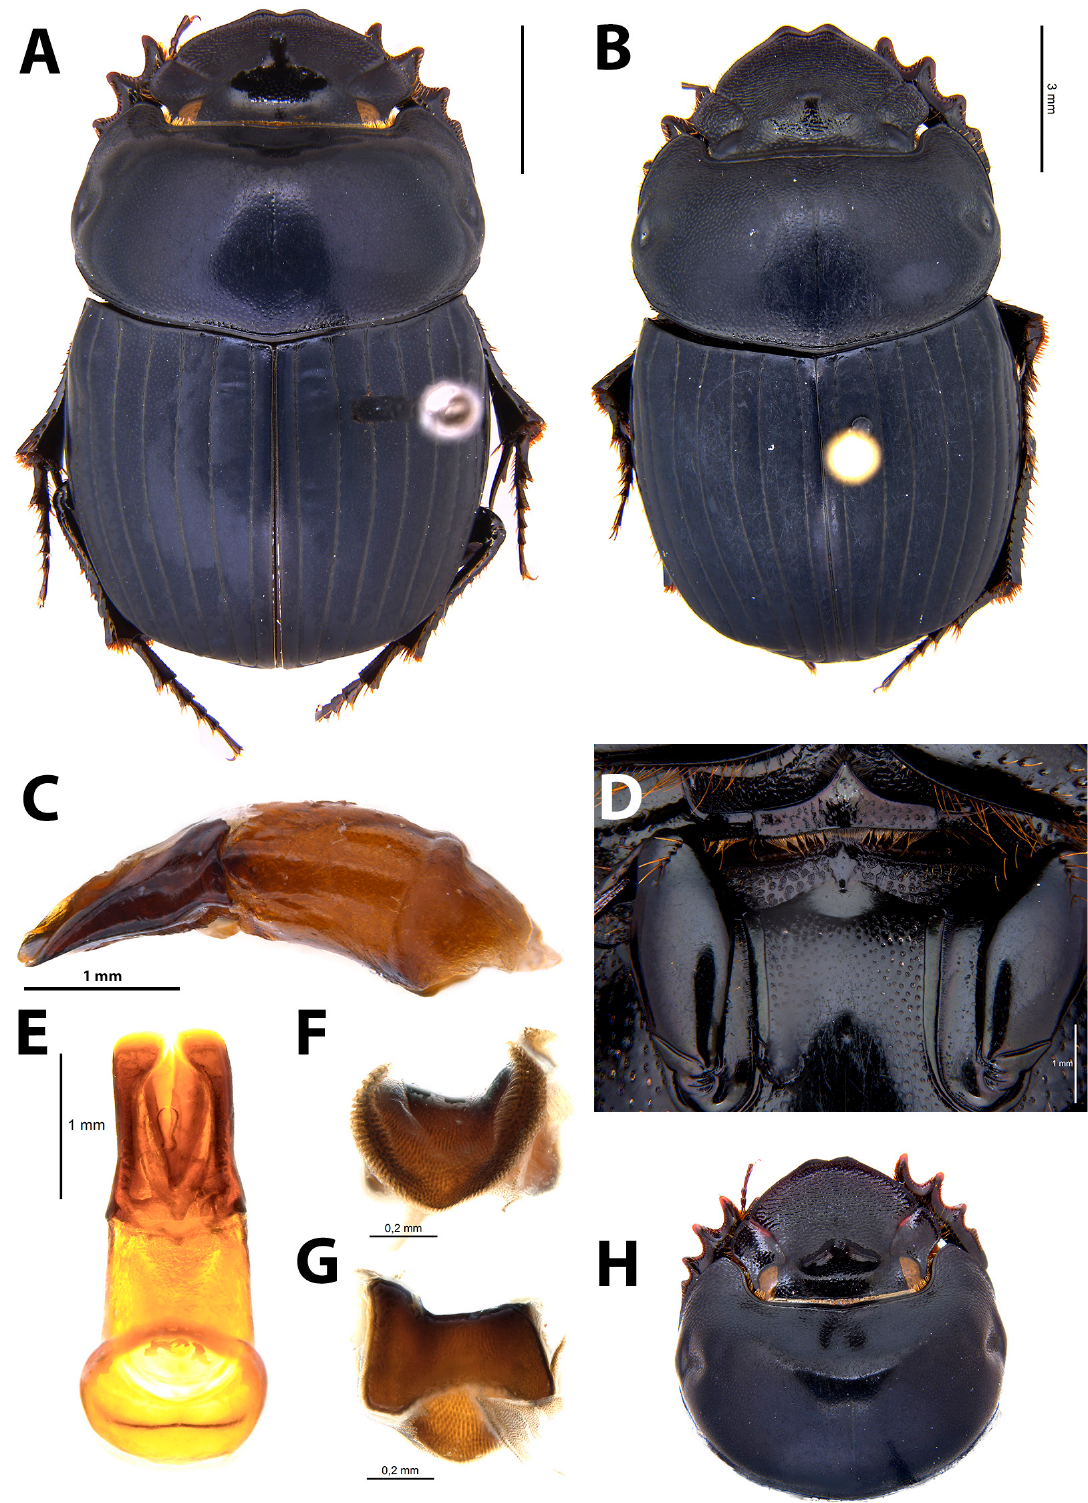
Fig. 9. Dichotomius fornicatus (Luederwaldt, 1931). A–B . Dorsal habitus. A . ♂. B . ♀. C . Lateral view of the aedeagus. D . Ventral view of the metasternum. Antero-medial edge smooth and shiny, surface near the interior margin of the mesocoxae punctate. E. Ventral view of the aedeagus. F–G . Lamella copulatrix. H . View from above of the head, cephalic carina